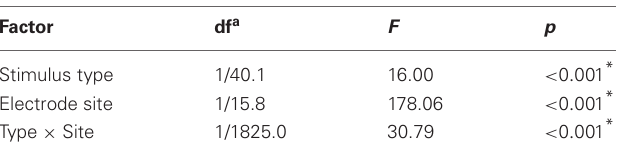
Table 1 | Linear mixed model fixed effects results for the normalized localizations.